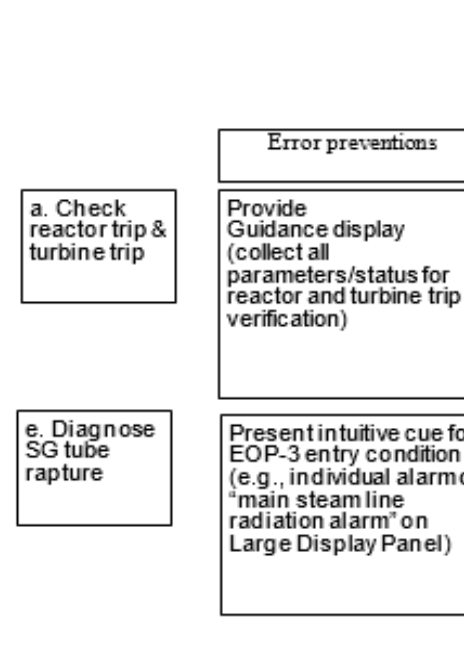
Figure 6. Design countermeasures.